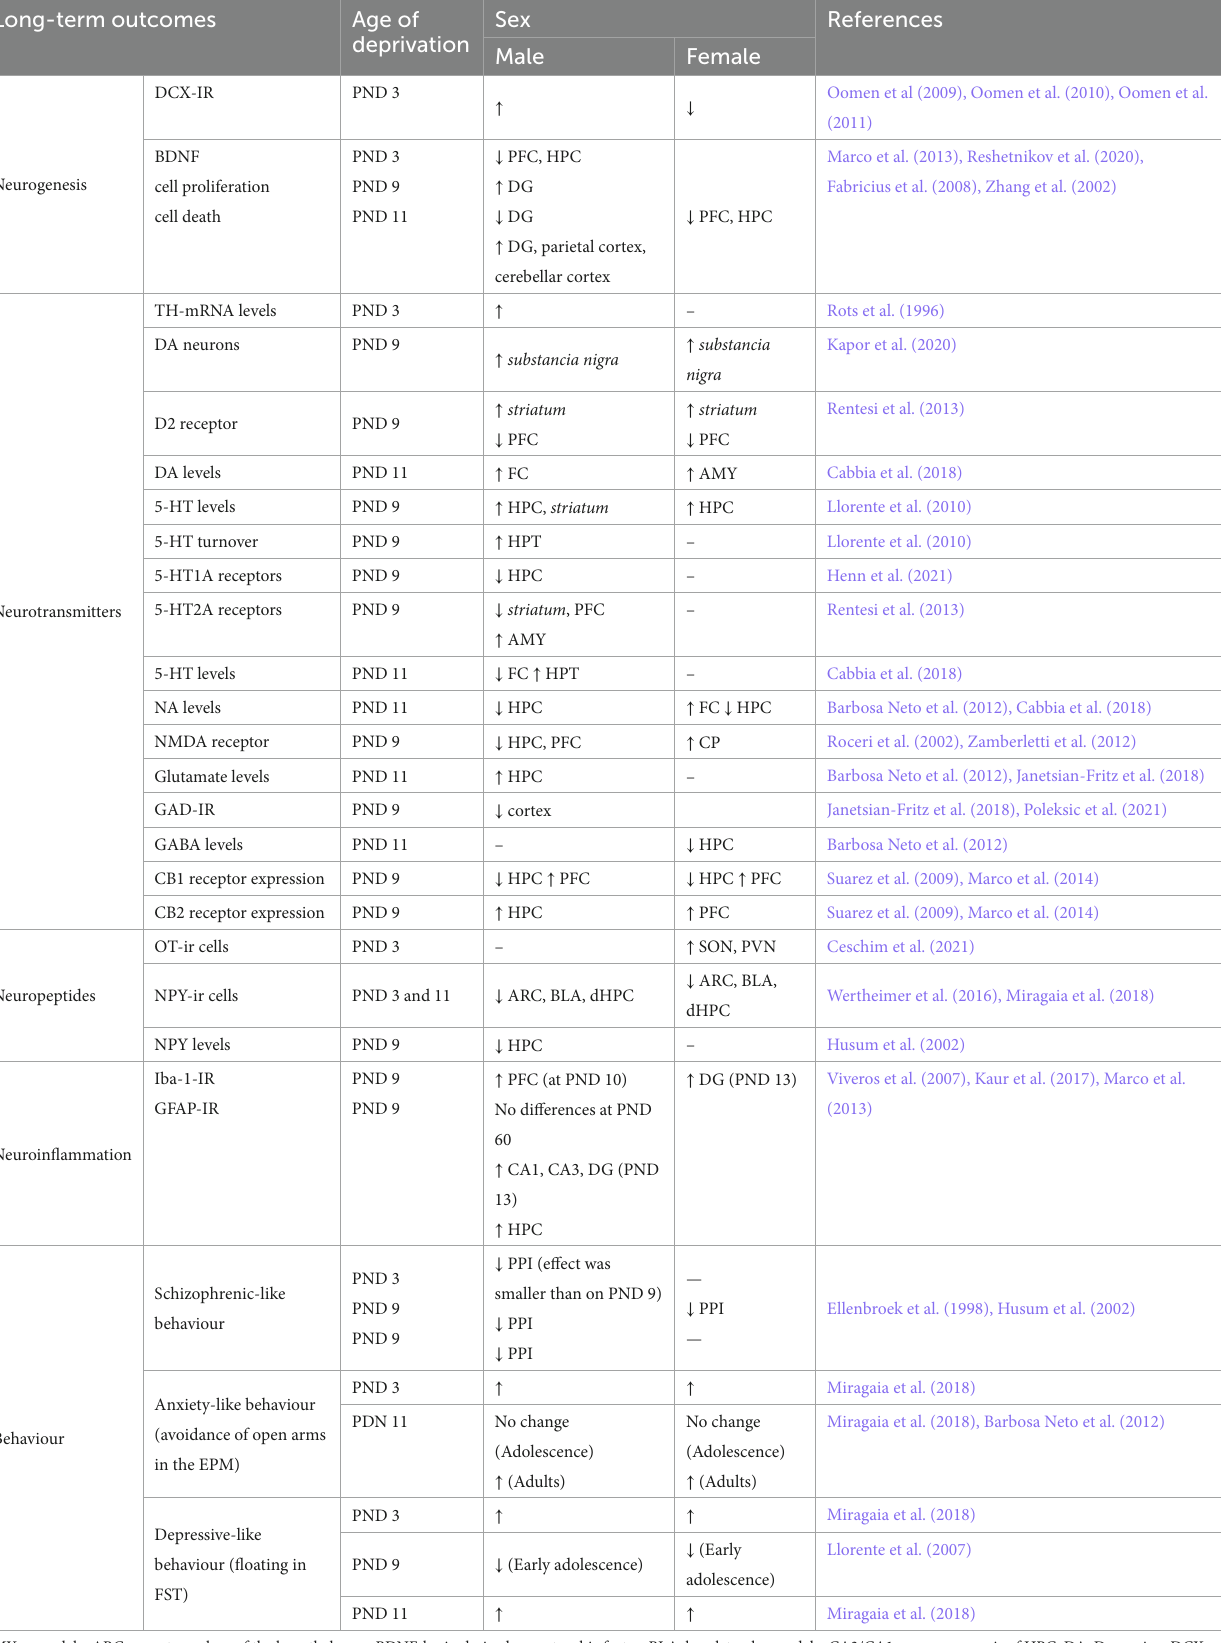
TABLE 1 Effects of maternal deprivation on different neurobiological systems and behaviours. Long-term